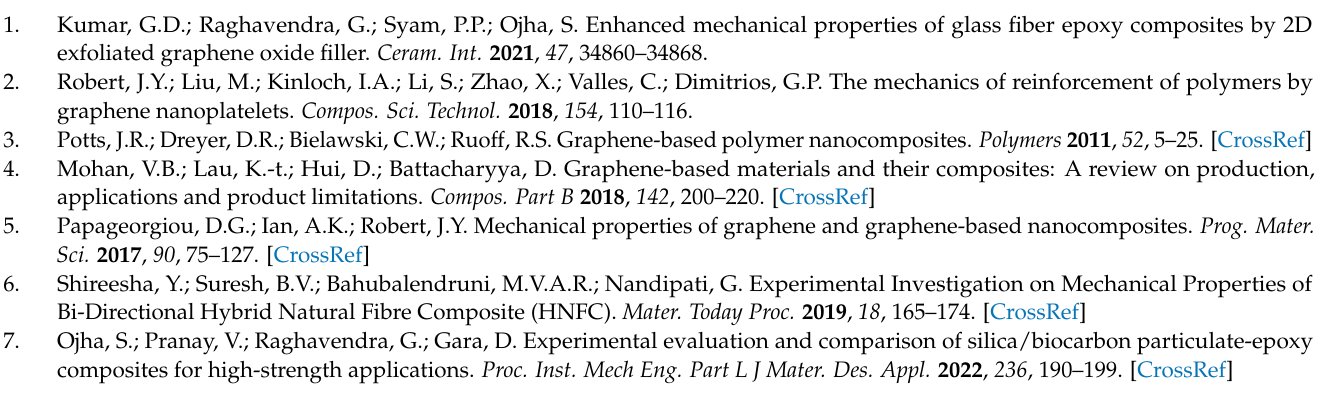
failure of GE and its nanocomposites (CP). Figure S2: Flexural failure of GE and its nanocomposites (AP). Figure S3: Interlaminar shear failure of GE and its nanocomposites (CP). Figure S4: Interlaminar shear failure of GE and its nanocomposites